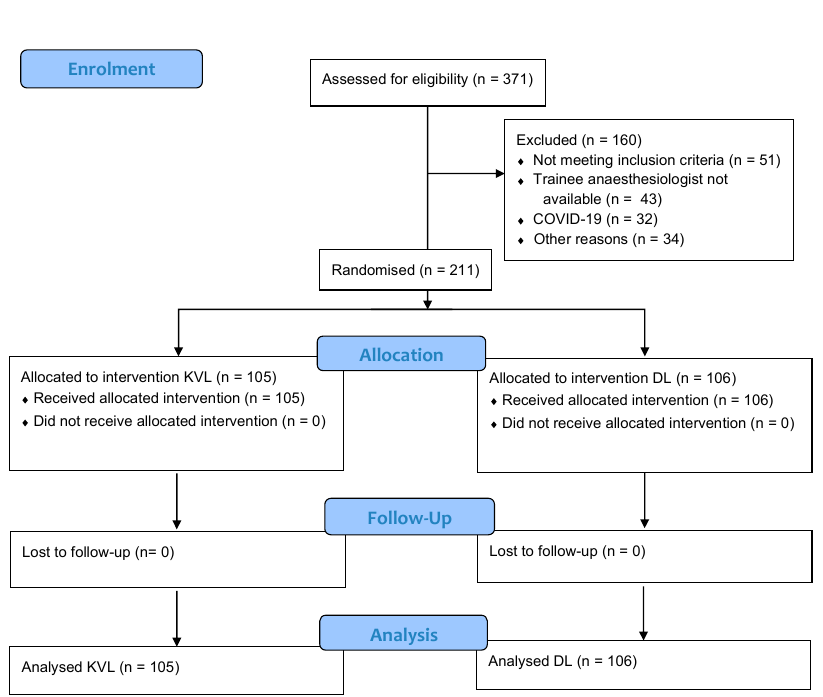
Figure 2. Consort flow diagram for patients in the study. Patient and trainee characteristics were comparable (Table 1). There were no outright